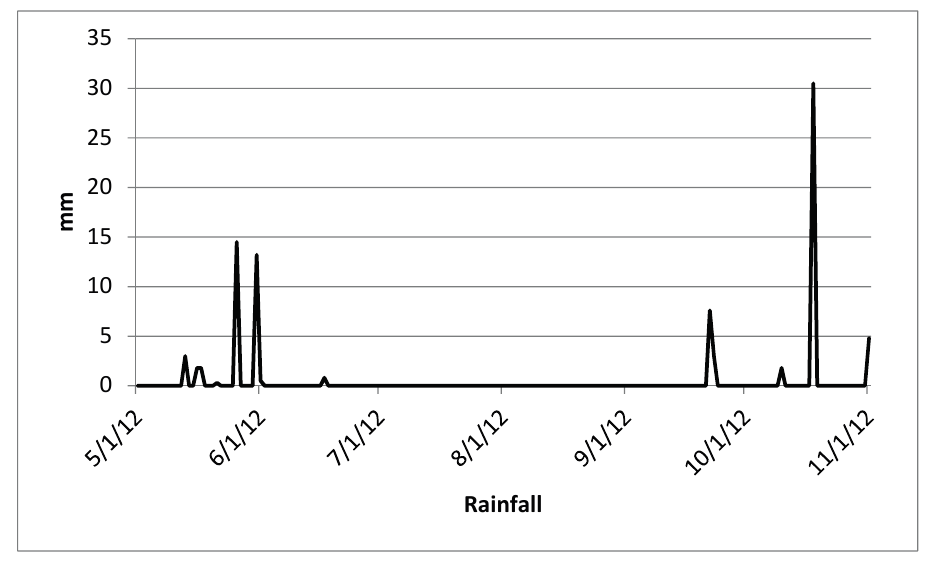
Figure 5. Rainfall in the studied period monitored by the meteorological stations from Embrapa Cerrados. Source: Laboratory of Environmental Biophysics at Embrapa